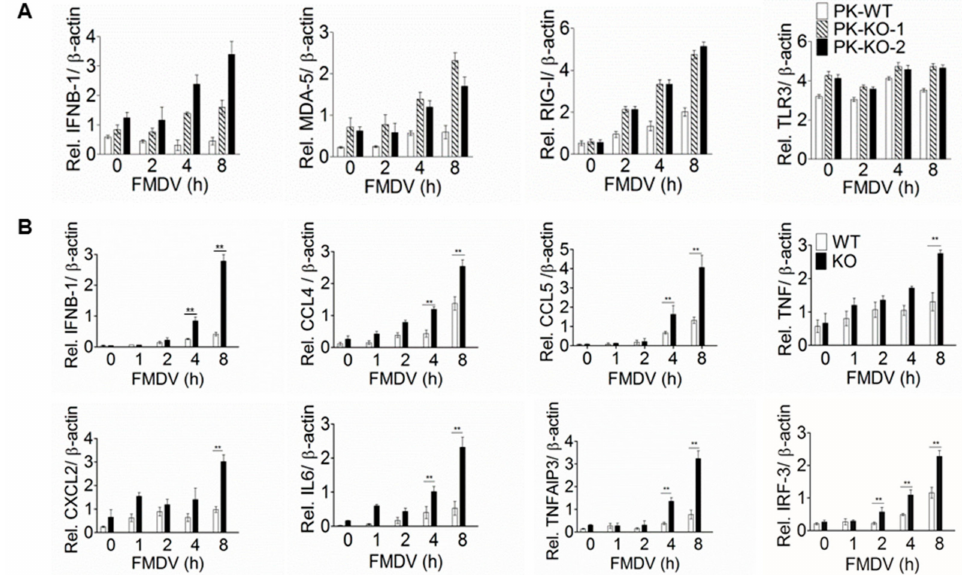
Figure 4. Knockout of p53 enhanced the expression of immune-related genes. ( A ) Knockout of p53 in PK-15 enhanced the expression of IFNB-1 and virus sensors upon FMDV infection. WT PK-15 and two p53 knockout cell lines were seeded in 60-mm dishes and were then infected with FMDV (MOI = 0.1). At the indicated time points, cells were collected for RT-qPCR to detect the expression level of IFNB-1, MDA-5, RIG-I and TLR3. ( B ) Expression of IFNB-1 and several cytokines was significantly increased in the primary peritoneal macrophages isolated from p53-KO mice. Primary peritoneal macrophages were respectively isolated from WT and p53-KO mice and cultured in 12-well plates. Cells were then infected with FMDV (MOI = 0.1) and harvested at the indicated time points. RT-qPCR was used to detect the relative expression of IFNB-1 and the other cytokines. The experiments were performed in triplicates and the bars are SD. ** indicates significant di ff erences at p < 0.01 according to Student’s t test. β -actin was used as the internal